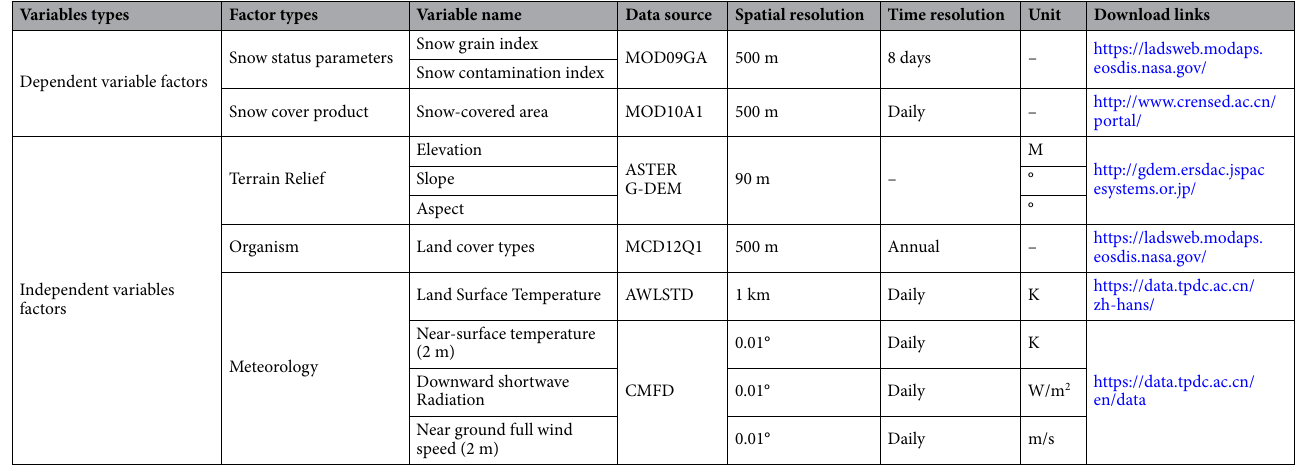
Table 1. Description of potential snow melting predictor variables used in this